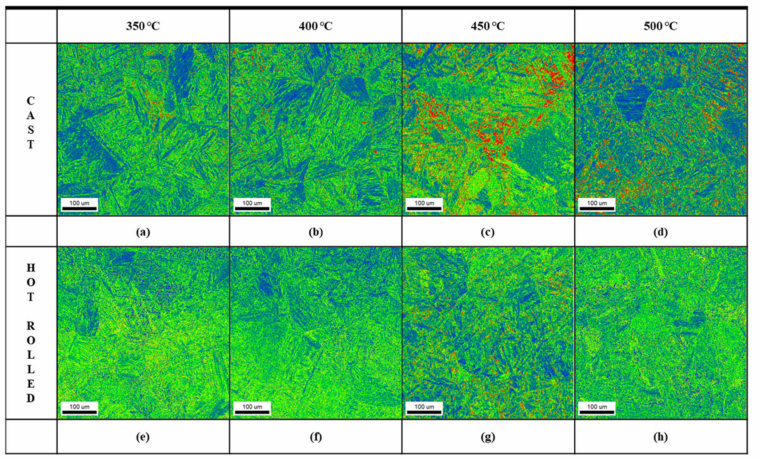
Figure 9. EBSD KAM maps of medium-carbon low-alloy steel isothermally heat treated for 240 min: cast steel heat treated at ( a ) 350 ◦ C, ( b ) 400 ◦ C, ( c ) 450 ◦ C, and ( d ) 500 ◦ C and hot-rolled steel heat treated at ( e ) 350 ◦ C, ( f ) 400 ◦ C, ( g ) 450 ◦ C, ( h ) and 500 ◦